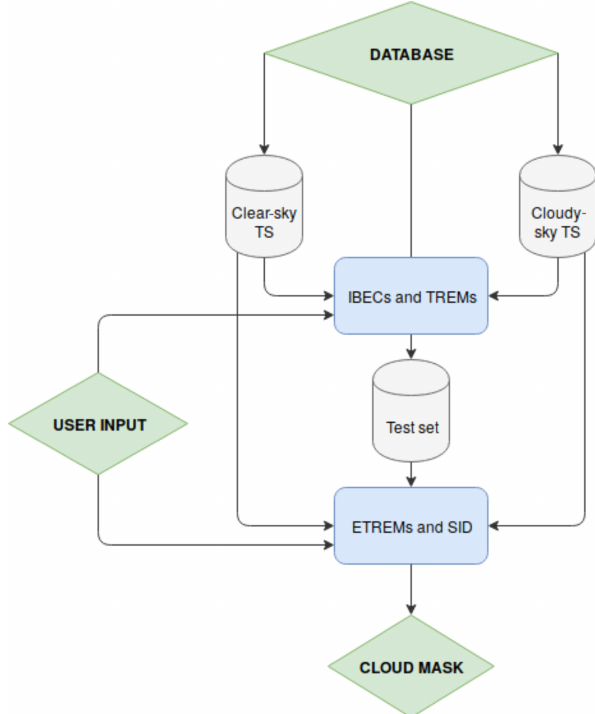
Figure 6. Scheme of the dataflow used for the cloud detection pro-